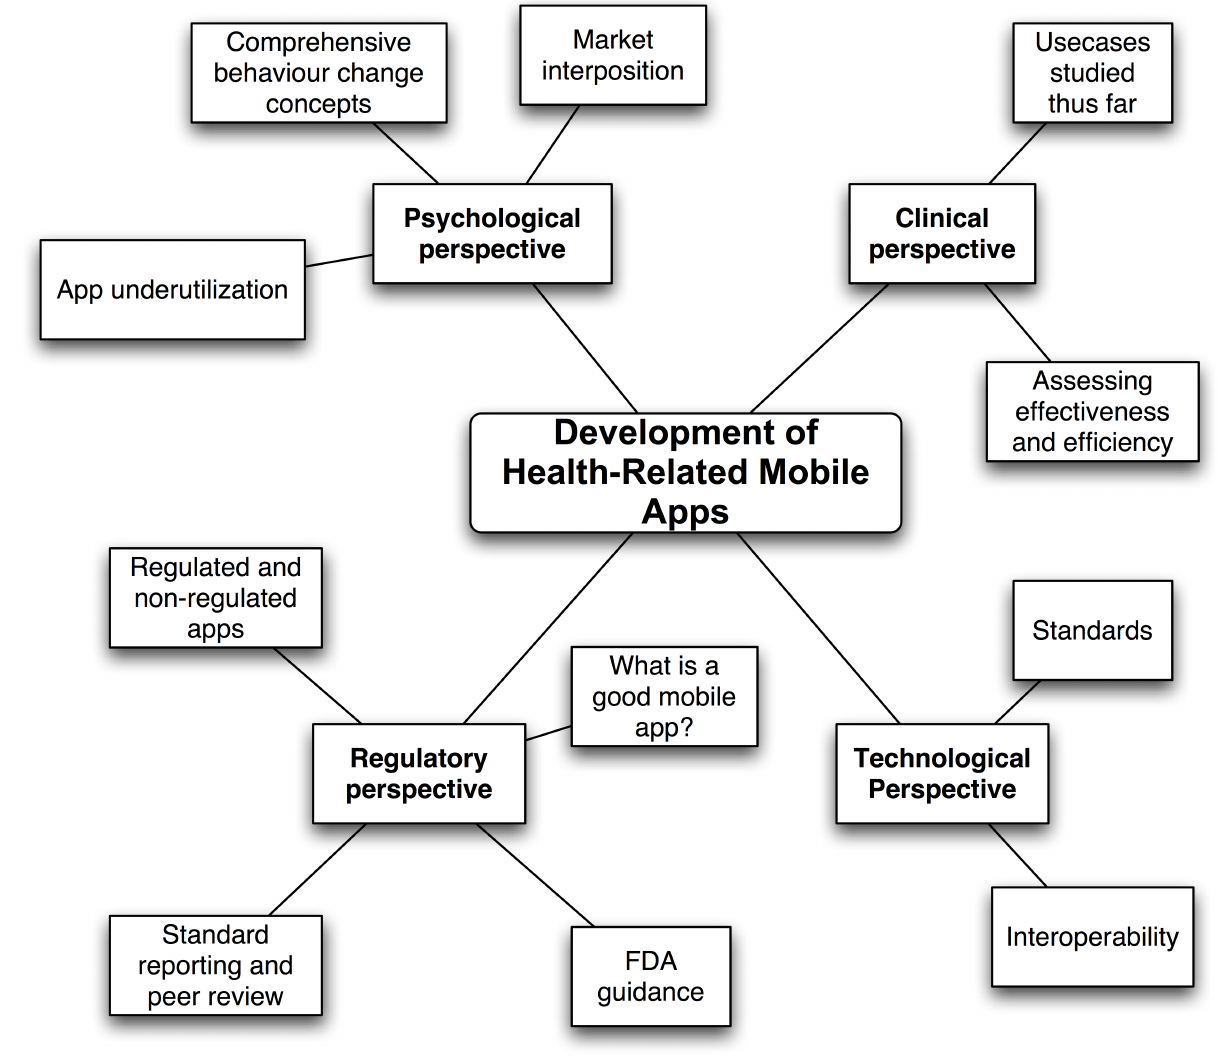
Figure 1. Development of health-related mobile applications and necessary